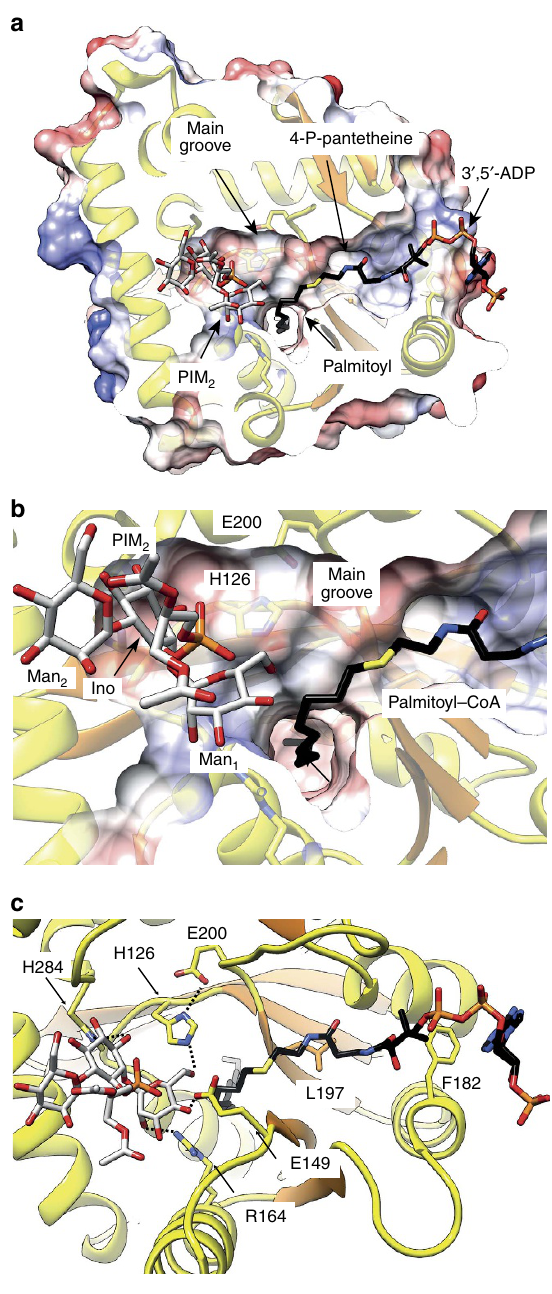
Figure 6 | The phosphatidylinositol mannosides binding site. ( a , b ) Two views showing the docking calculations in which PIM 2 attaches to the end side of the main groove, close to the hydrophobic tunnel. ( c ) Close view of the binding site, showing the location of predicted residues involved in PIM 2 interaction that have been mutated (H126, E149, R164, H284) along with mutated residues involved in CoA binding (L197 and